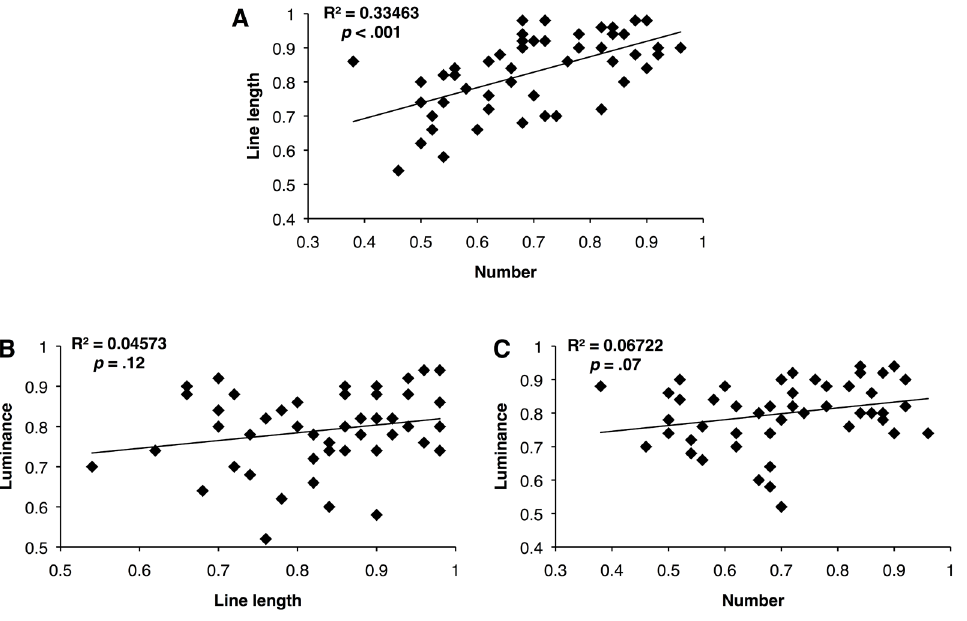
Figure 3. Correlational analyses illustrating the relation between children’s performance in the different magnitude comparison tasks. Number and line length (A) are significantly correlated whereas line length and luminance (B) and number and luminance (C) do not exhibit a significant correlation.